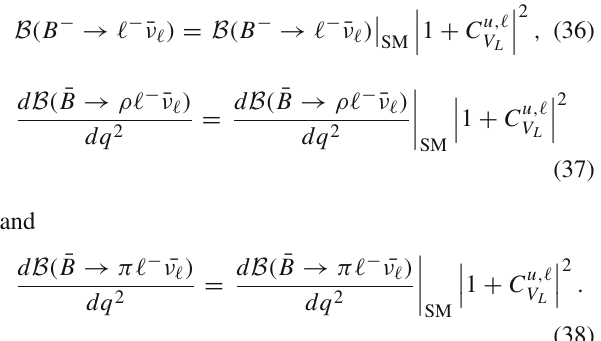
,μ and C u , as indicated in the P P